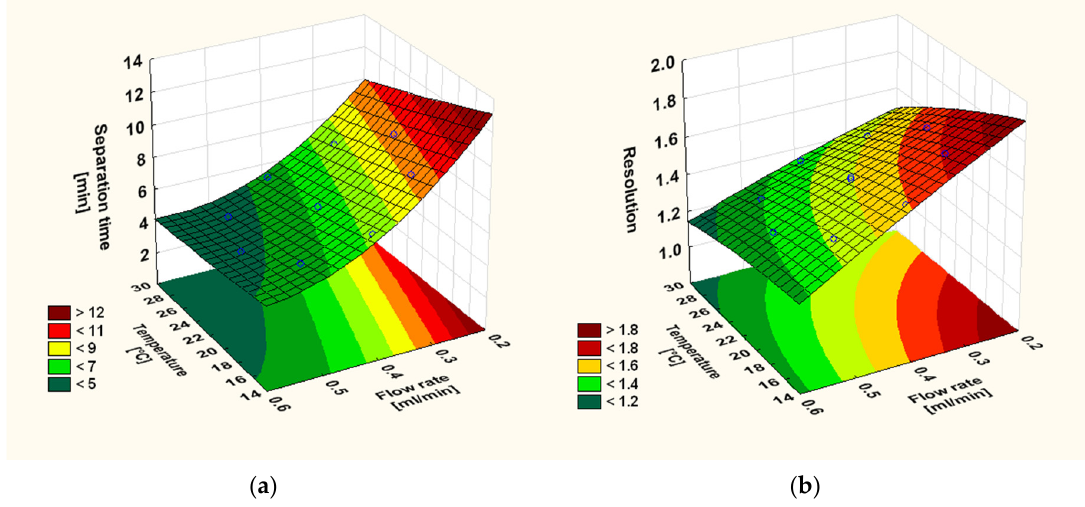
Figure 3. Response surface for: ( a ) the resolution and ( b ) separation time estimated from the central composite design as a function of flow rate and temperature.